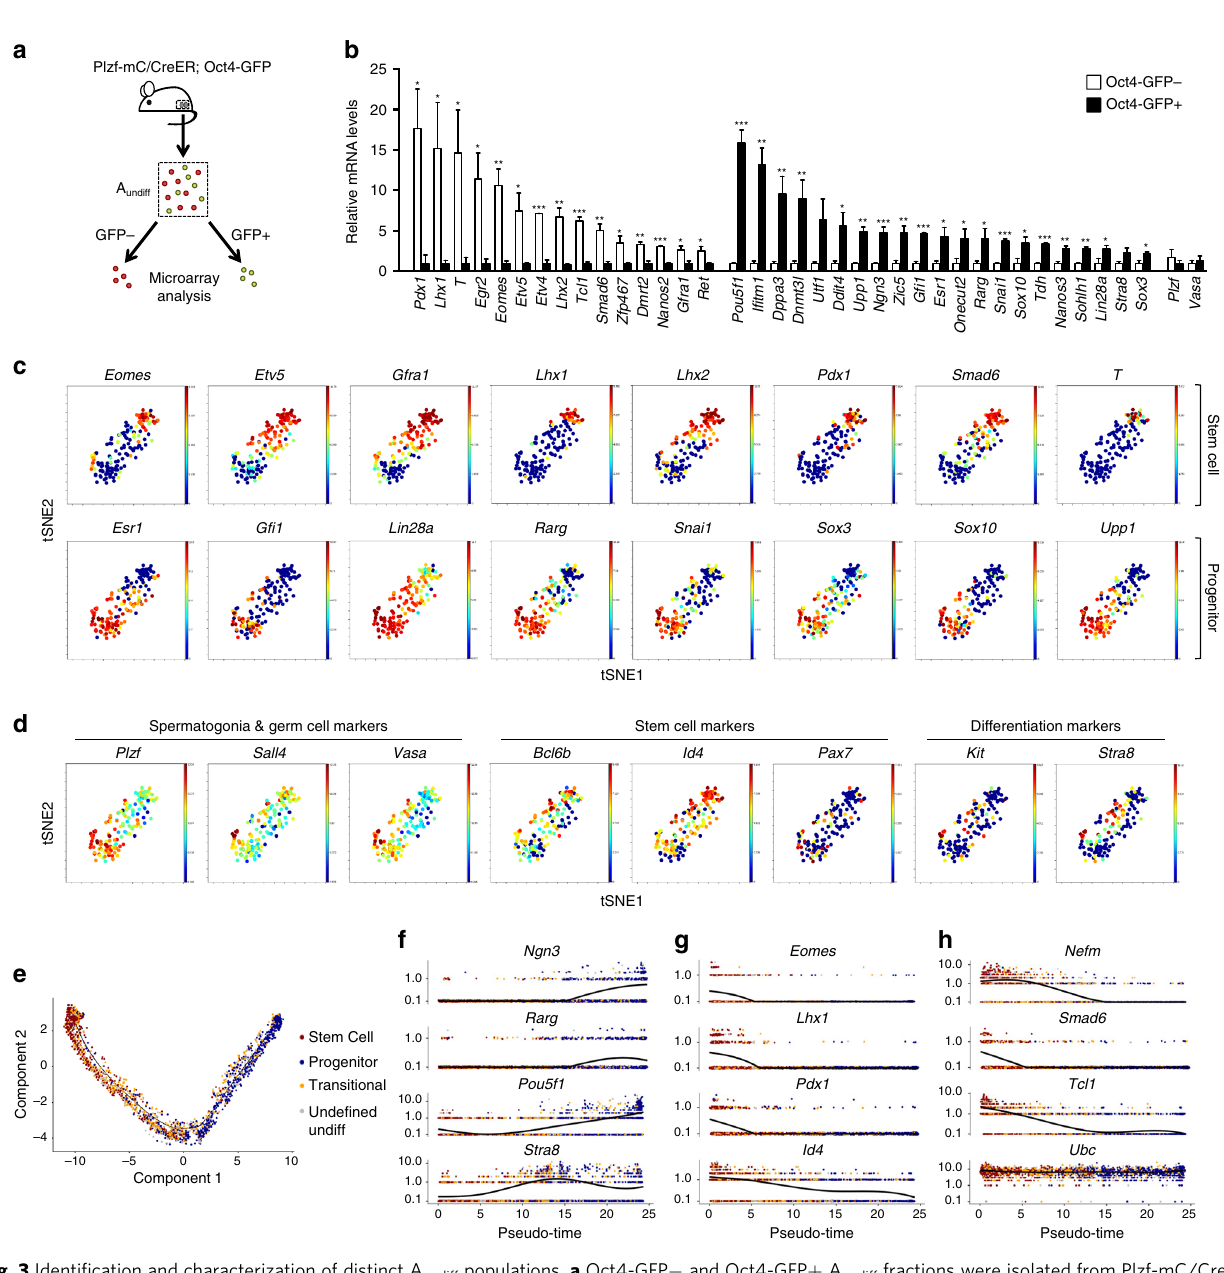
Fig. 3 Identi fi cation and characterization of distinct A undiff populations. a Oct4-GFP − and Oct4-GFP + A undiff fractions were isolated from Plzf-mC/CreER; Oct4-GFP adults for gene expression pro fi ling by microarray. A undiff fraction is mCherry + CD9 + c-KIT − . b Con fi rmation of gene expression signatures of Oct4-GFP − and Oct4-GFP + A undiff by quantitative RT-PCR. Candidate genes were selected from microarray analysis of a . Expression levels are corrected to those of β -actin and normalized so mean value of GFP − or GFP + fractions equals 1. Mean values from 3-5 mice ± s.e.m. are indicated. Genes enriched in Oct4-GFP − and Oct4-GFP + populations are shown in separate groups. Control genes Plzf and Vasa are shown. Signi fi cance was calculated by two-tailed Student ’ s t -test (* P < 0.05, ** P < 0.01, *** P < 0.001). c viSNE maps derived from single cell analysis of 150 single A undiff cells isolated from pooled adult Plzf- mC/CreER testis. Based on expression of a total of 71 genes identi fi ed from analysis of A undiff fractions in b plus genes previously linked with A undiff function. Relative expression of selected genes associated with stem and progenitor fractions by each plotted cell is indicated (red = high, blue = low). d viSNE maps from single cell analysis of c . Spermatogonial and germ cell markers are in left panels. Middle panels show stem cell markers not identi fi ed as differentially expressed in Oct4-GFP − and GFP + A undiff fractions by microarray. Differentiation markers are in right panels. e A undiff isolated from 2 Plzf- mC/CreER; Oct4-GFP adults were analysed by single cell RNA-Seq and developmental trajectory calculated using Monocle. Cells were classi fi ed as follows: Stem cells ( Gfra1 or Etv5 positive), progenitors ( Sox3 or Upp1 positive), transitional cells (positive for combinations of stem and progenitor genes) and unde fi ned undiff (negative for these stem and progenitor genes). f − h Expression of indicated genes across cell trajectory (pseudotime) from single cell analysis of A undiff in e . Expression of housekeeping gene Ubc is